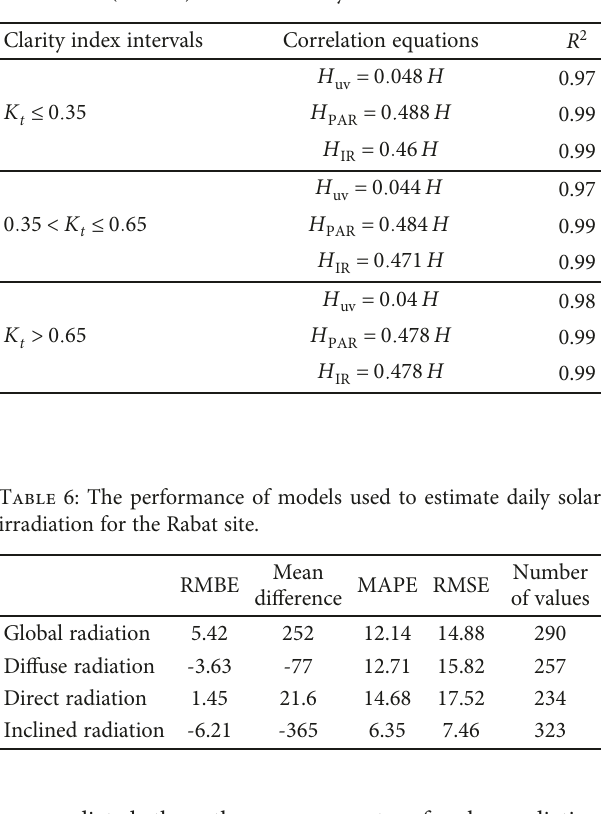
Table 4: The equations used for the global radiation extrapolation in Morocco.